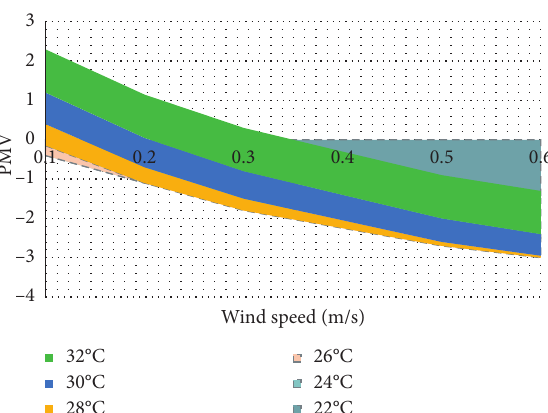
Figure 3: The influence of wind speed on PMV under different air